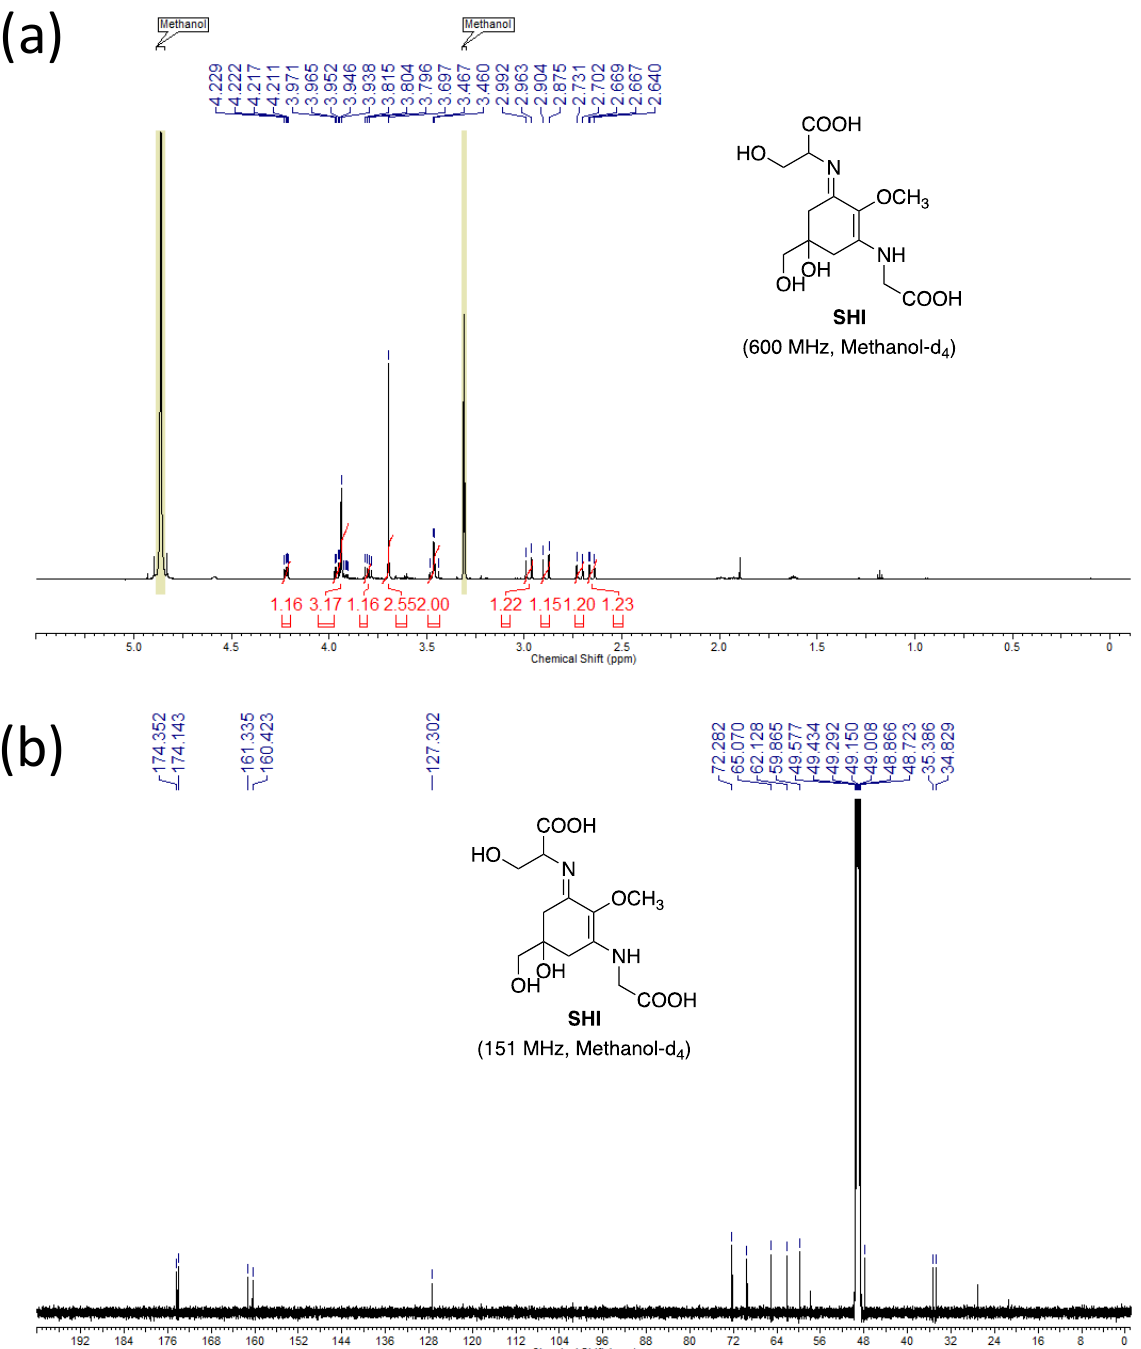
Figure 5. NMR spectra of SHI. ( a ) 1 H NMR and ( b ) 13 C NMR spectra are shown.